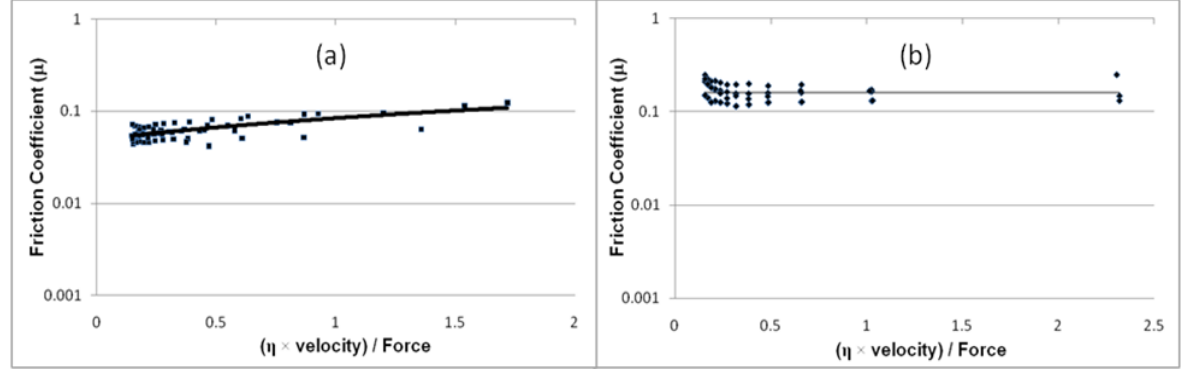
Figure 3. ( a ) Coefficient of friction for untreated VSMCs plotted versus an approximated Sommerfeld number. The data points are from 5 separate VSMCs, and were fit with a linear trendline, R 2 = 0.539; ( b ) Coefficient of friction for glutaraldehyde-treated VSMCs plotted versus an approximated Sommerfeld number. The data points are from 5 separate VSMCs, and were fit with a linear trendline, R 2 = 5 × 10 –5